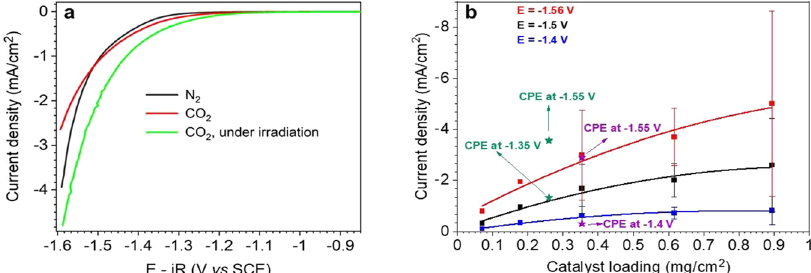
Fig. 4 CO2RR activity of Cu-GCN in KHCO 3 . a Linear sweep voltammetry in N 2 - and CO 2 -saturated 0.5 M KHCO 3 in dark and illuminated conditions recorded at 5 mVs − 1 and 3500 rpm on Cu-GCN(20) using a catalyst loading of 0.354 mg cm − 2 ; and b current density values at − 1.4 V (blue), − 1.5 V (black), and − 1.56 V vs SCE (red) recorded at 5 mVs − 1 and 3500 rpm in CO 2 -saturated 0.5 M KHCO 3 using different catalyst loadings. The error bars were calculated by performing at least two experiments. Purple stars in ( b ) are related to chronoamperometric measurements in a completely sealed cell, while green stars correspond to chronoamperometric measurements under the continuous fl ow of CO 2